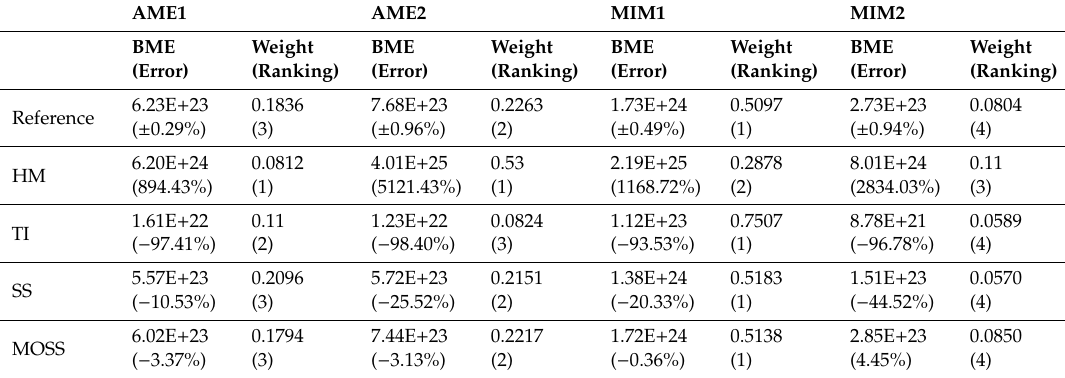
Table 7. BME (BME Relative Error [%]) and model weight (model ranking) for the candidate modes using harmonic mean (HM), thermodynamic integration (TI), steppingstone sampling (SS) and multiple one-steppingstone sampling (MOSS), for K = 5 and n = 10,000 samples per K